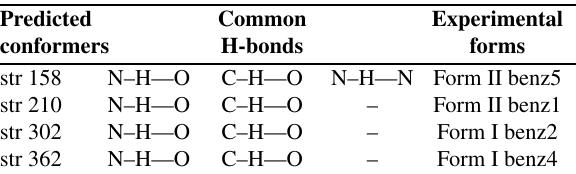
Table 3. Common intermolecular H-Bonds between the experi- mental and Predicted conformers.